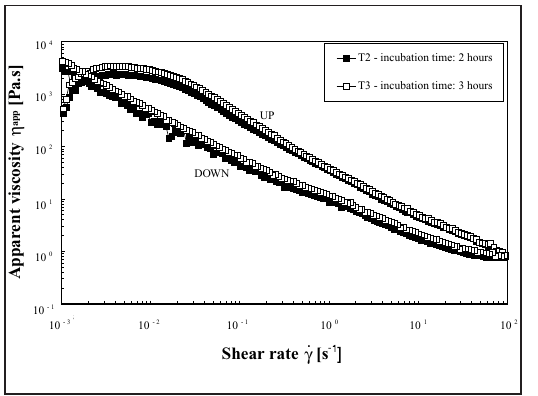
Figure 1: Representative upward and downward flow curves of set-style yoghurt with different incubation times (T2 and T3 yoghurt